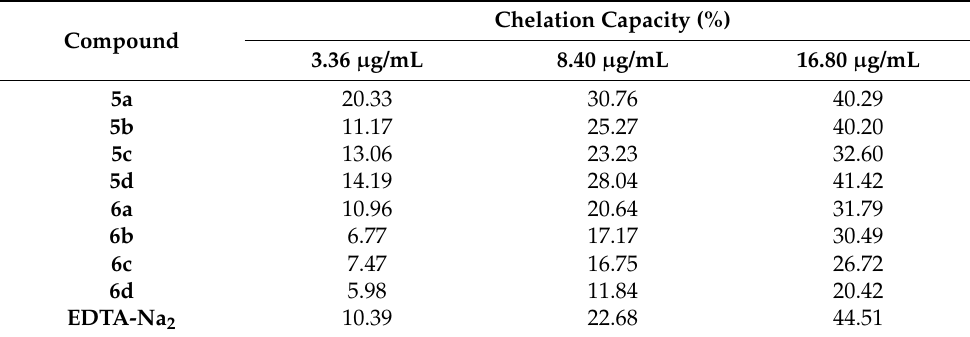
Table 6. Results of the cupric ions chelation capacity evaluation.